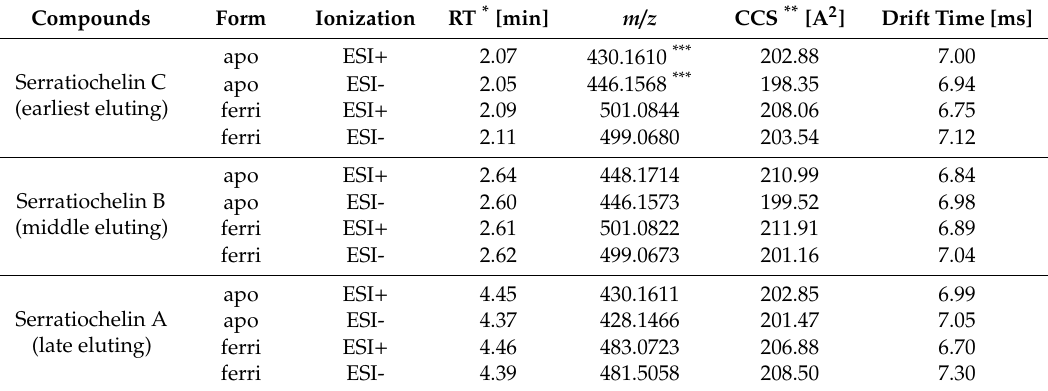
Table 2. IMS and MS data for the apo- and ferrylspecies of serratiochelin A ( 1 ), serratiochelin B, and serratiochelin C ( 2